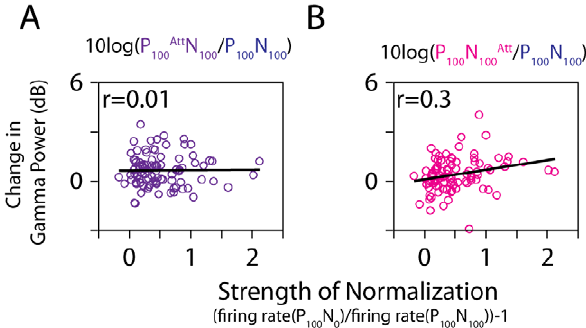
Figure 8. Comparison of normalization and attention on a neuron-to-neuron basis. (A) For each neuron, the degree of normalization ( a ), defined as firing rate(P 100 N 0 )/firing rate (P 100 N 100 ) 2 1 ( x -axis), is plotted against the relative change in gamma power when attention is directed to a preferred stimulus versus outside: log10(gamma power(P 100Att N 100 )/gamma power(P 100 N 100 )) ( y -axis). The Spearman rank correlation is indicated on the top. The black line indicates the best fit obtained through linear regression. (B) Same analysis when attention is directed to the null stimulus.